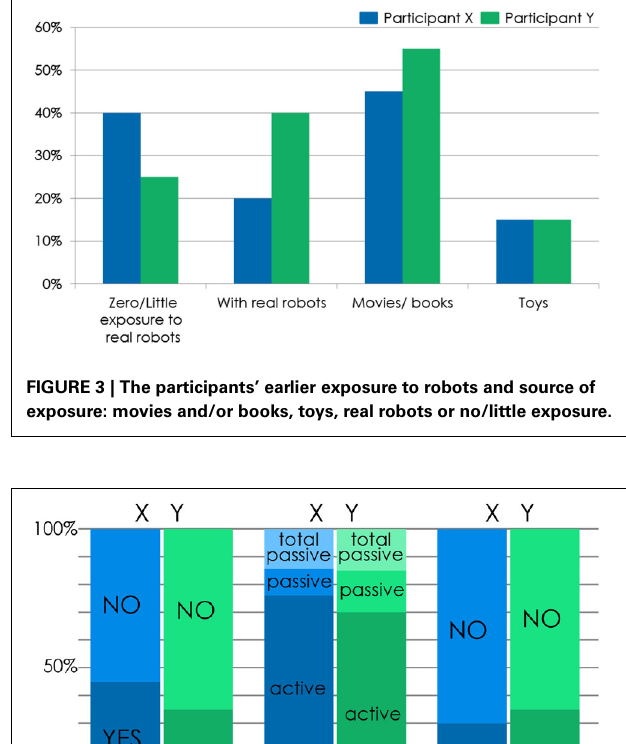
(Baddoura et al., 2012). Generally, most of the participants (70% of the 40 participants) have never been exposed to a real robot before. t -test results showed that the difference between X and Y